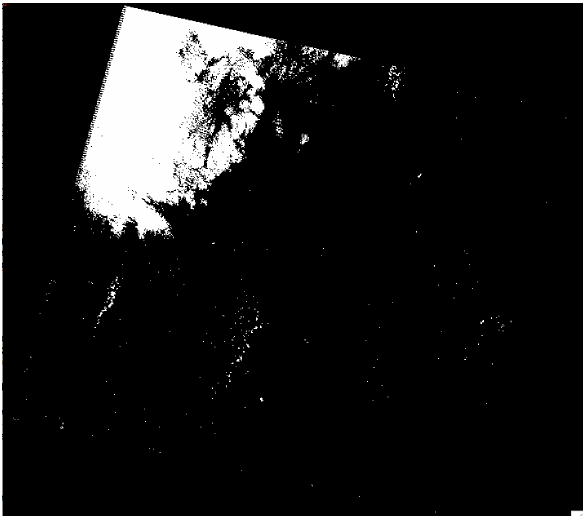
Figure 6: One example of a cloud product provided with the Landsat surface reflectance product. White pixels are classified as cloudy.